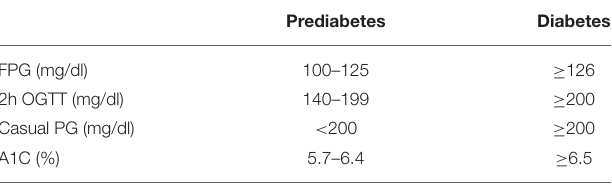
TABLE 2 | Effects of body composition on cardiometabolic risk in the Middle